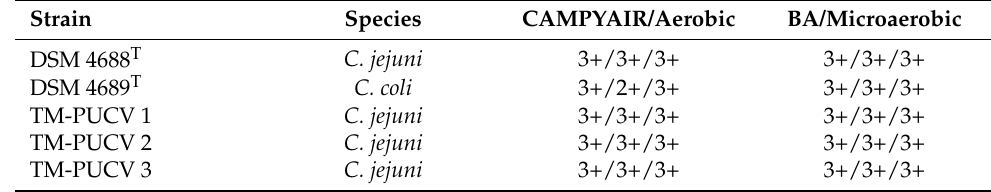
Table 3. Qualitative growth of strains C. jejuni (ATCC 33560 T ) and C. coli (DSM 4689 T ) and 10 clinical strains on BA incubated under microaerobic conditions and on CAMPYAIR incubated under aerobic conditions.